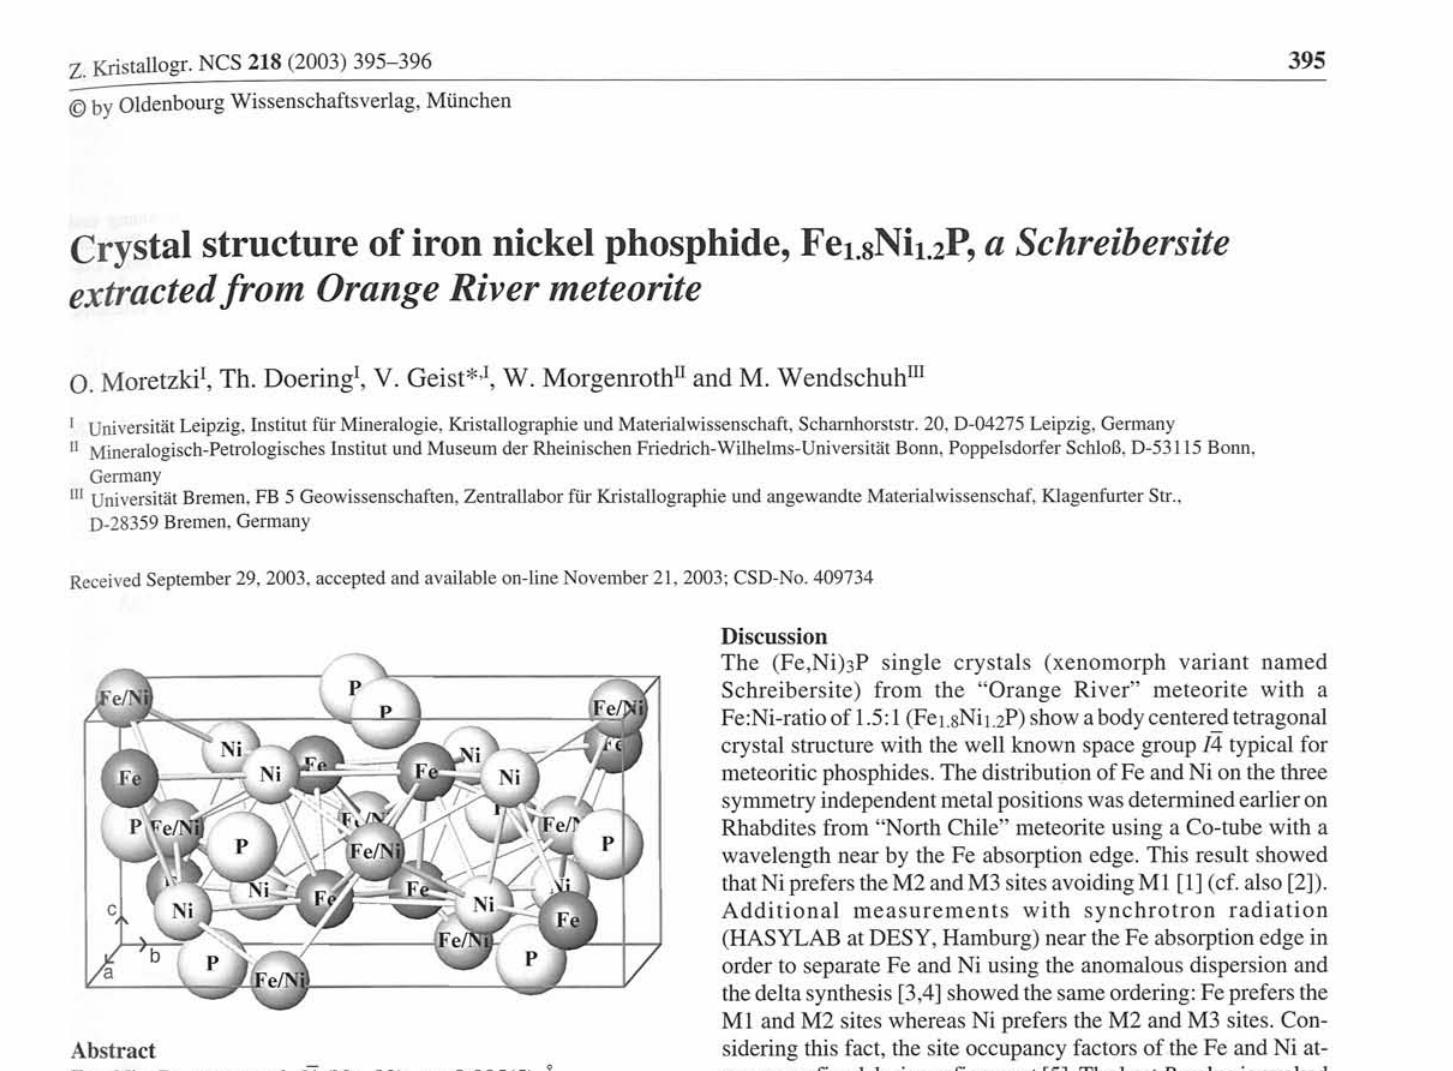
Table 1. Data collection and handling.